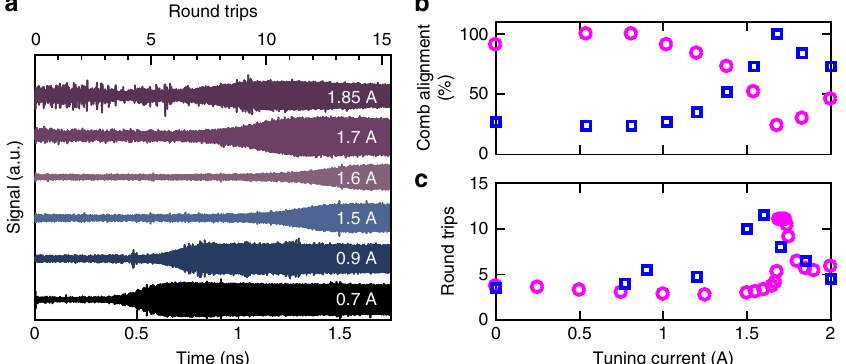
Fig. 5 Coherent measurement of the electric fi eld emitted from the coupled-cavity laser for different currents supplied to the tuning cavity. a Electric fi eld emitted from the output facet of the tuning cavity, measured as a function of time for different currents supplied to the tuning section as indicated (offset for clarity). The lasing cavity is driven using quasi-direct current pulses of amplitude 0.65 A (the noise apparent in the 1.85 A trace arose from external vibrations). b Comb alignment parameter calculated using the transfer matrix model at frequencies 2.765 THz (blue) and 2.825 THz (magenta). c Experimentally measured switch-on delay (blue) and laser stabilisation time (magenta) simulated using the reduced rate equation model (expressed as number of round trips), as a function of tuning